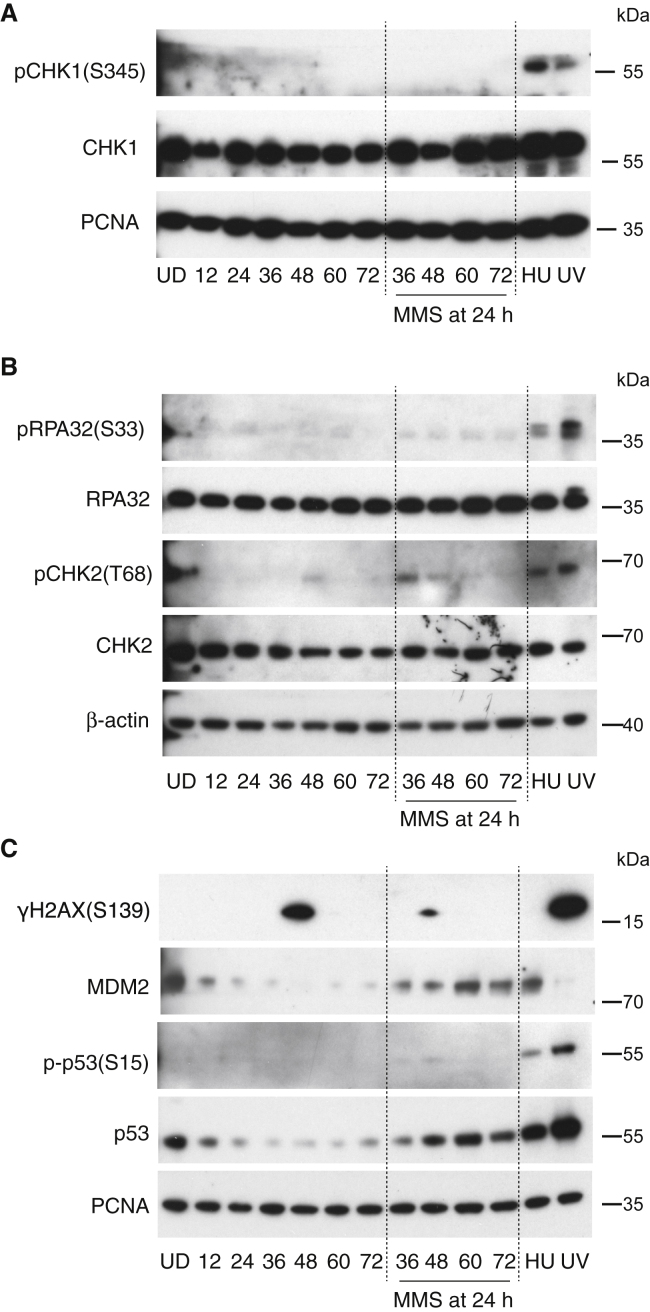
DNA Damage during Early Endoderm Differentiation Prevents Reduction of p53 LevelsWestern blot analyses of changes to the DNA-damage response during differentiation, with and without 5 ppm MMS treatment at 24 h. Protein was collected from whole-cell lysates every 12 h. Positive control samples were collected for protein 5 h after treatment, including 2 mM HU and 20 J/m2 UV-C.(A) Phospho-CHK1 (Ser-345) and total CHK1, with PCNA as a loading control.(B) Phosphorylation of RPA32 (Ser-33), total RPA, phosphorylation of CHK2 (Thr-68), total CHK2, and β-ACTIN as a loading control.(C) Phospho-H2AX (Ser-139), total MDM2, phospho-p53 (Ser-15), and total p53. PCNA is used as a loading control.